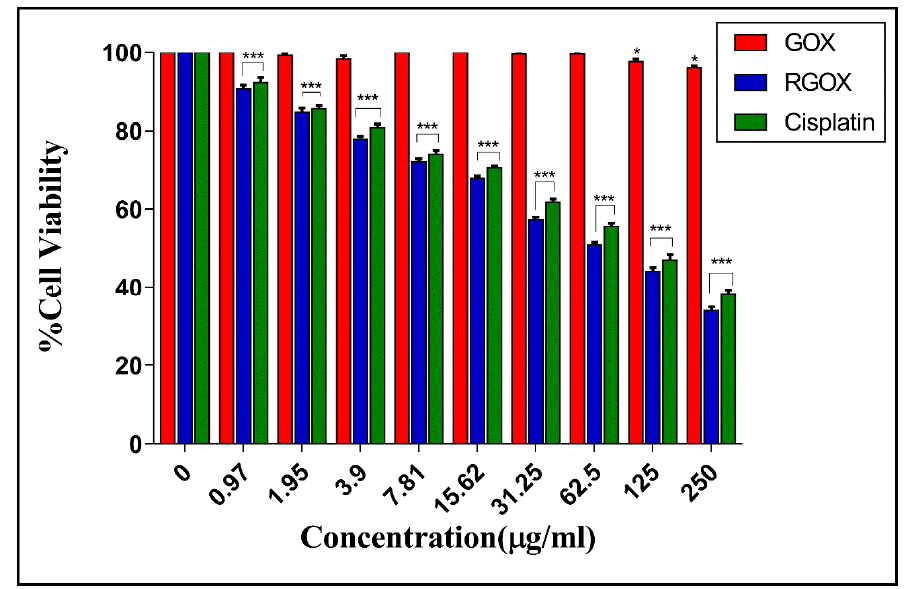
Figure 8. Cytotoxicity assay of MCF-7 cancer cells with increasing concentrations (0–250 µg/mL) of Cisplatin, GOX, and RGOX (p-value < 0.05 *, < 0.01 ** and < 0.001 ***).